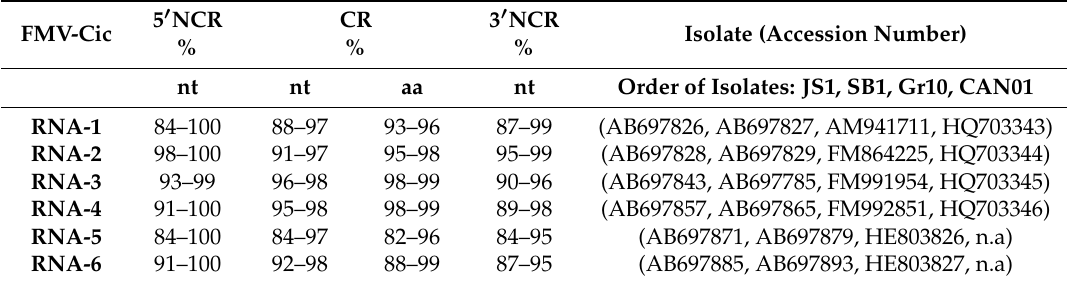
Table 1. Range of sequence identity matrix determined from nucleotides (nt) and deduced amino acids (aa) of each RNA segment of FMV-Cic and their homologues in other FMV isolates. n.a: not available. NCR: non-coding region. CR: coding